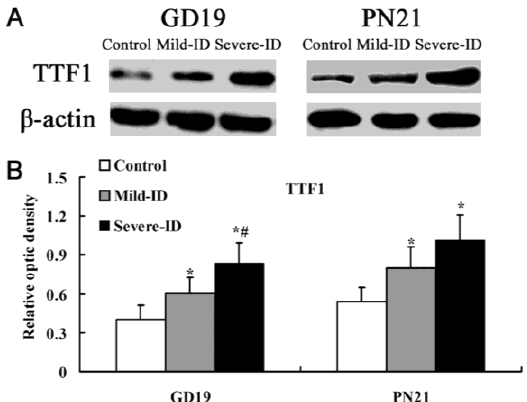
Figure 3. Up-regulated protein levels of TTF1 in the thyroid. The upper bands ( A ) depict representative findings for rats subjected to mild ID and severe ID, respectively. The lower bar graphs show the results of the semi-quantitative measurement of TTF1 ( B ) following mild ID and severe ID treatment. The height of each bar represents the mean ±SD for the groups. At each time point, * compared to the control, p < 0.05; # compared to the mild ID, p < 0.05 (n = 5).